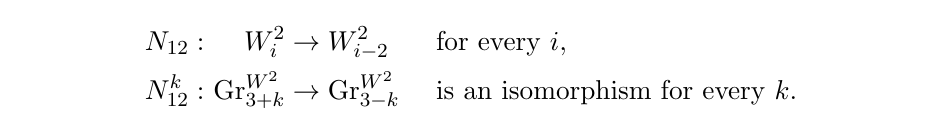
. The arrows show 1